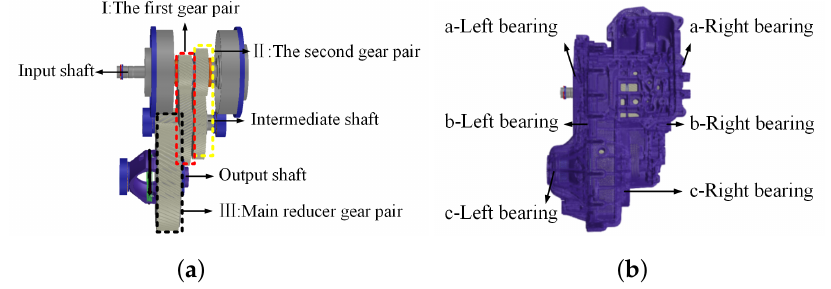
Figure 7. ( a ) Gear transmission system model of the automatic transmission. ( b ) Simulation model of the whole automatic